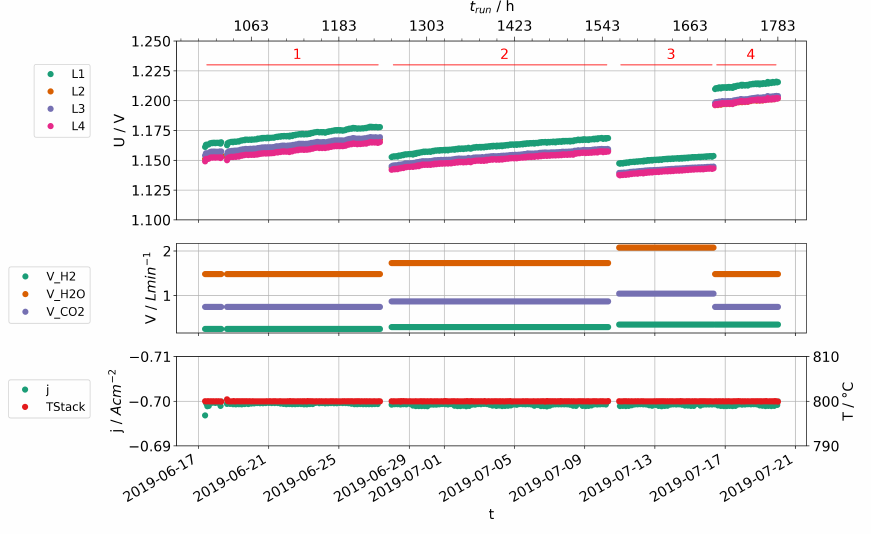
Figure 9. Daily averaged layer voltages (top), relative power (center), current density, and stack temperature (bottom) for stationary operation in stack B. The operational phases are indicated with red